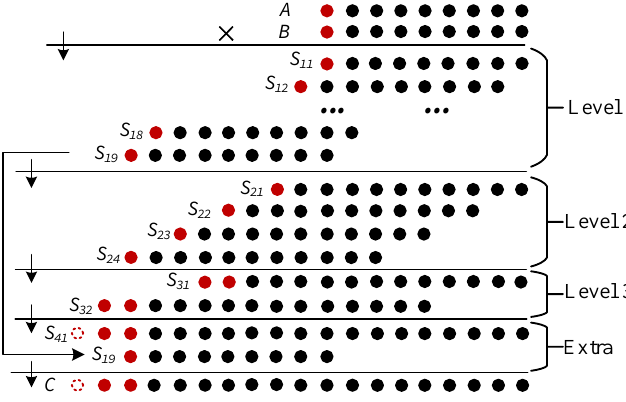
Figure 3: The process of a 8 × 8-digit RSD